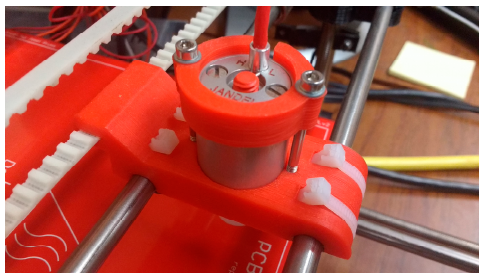
Figure 2. Printed four-point probe holder showing mounted four-point probe head. Materials 2017 , 10 , 110